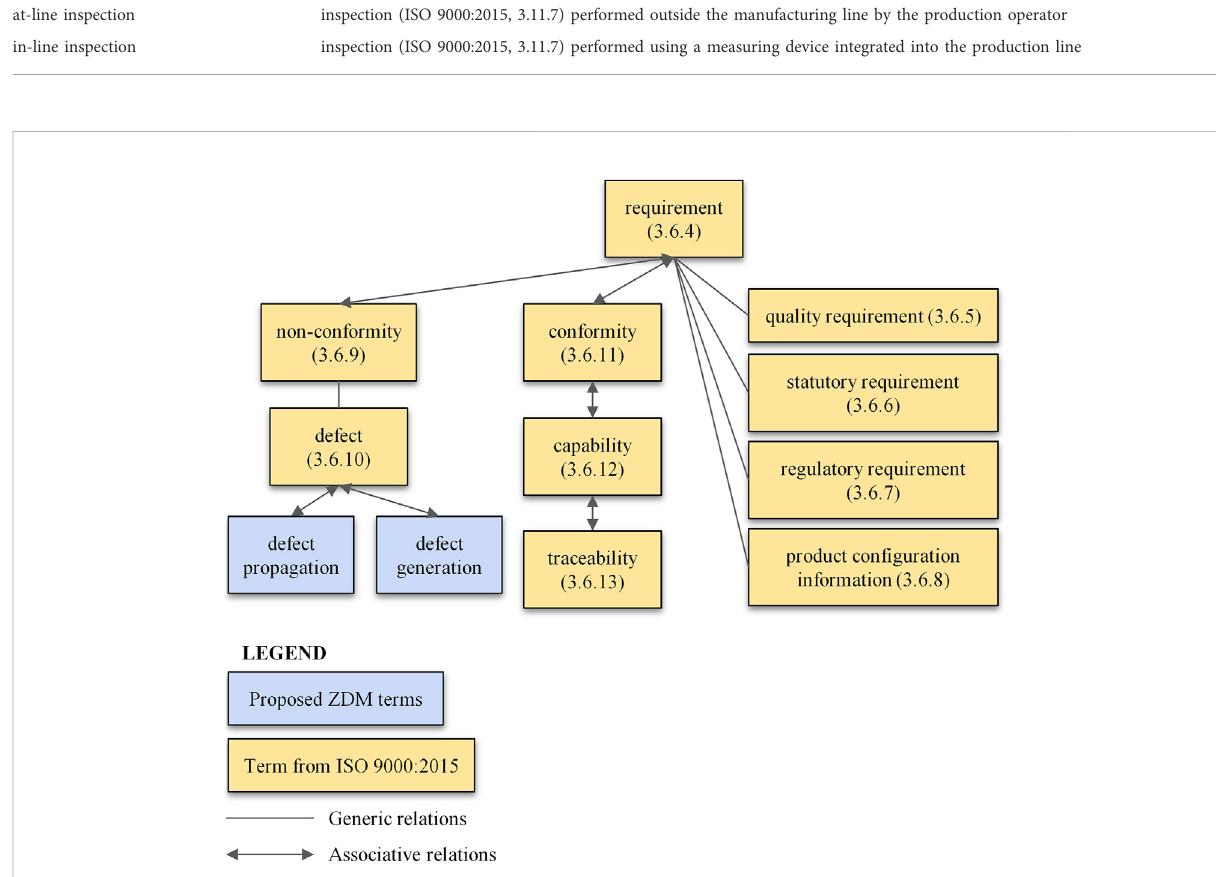
FIGURE 5 Some concepts related to requirement from ISO 9000:2015 and in relation with proposed ZDM term [adapted from (ISO, 2015b)]. Terms collected from ISO 9000:2015 include the entry number in that standard for better reference and traceability.